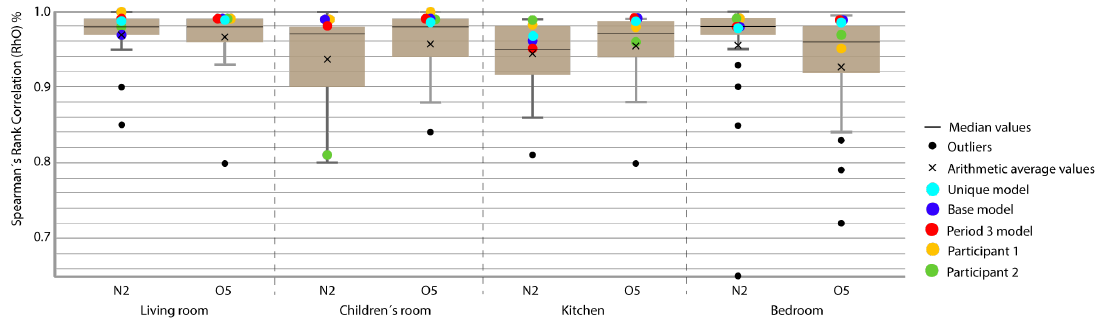
Figure 8. Temperature Spearman’s Rank Correlation Coefficient ( ρ ) for Period 3 (ROLBS).